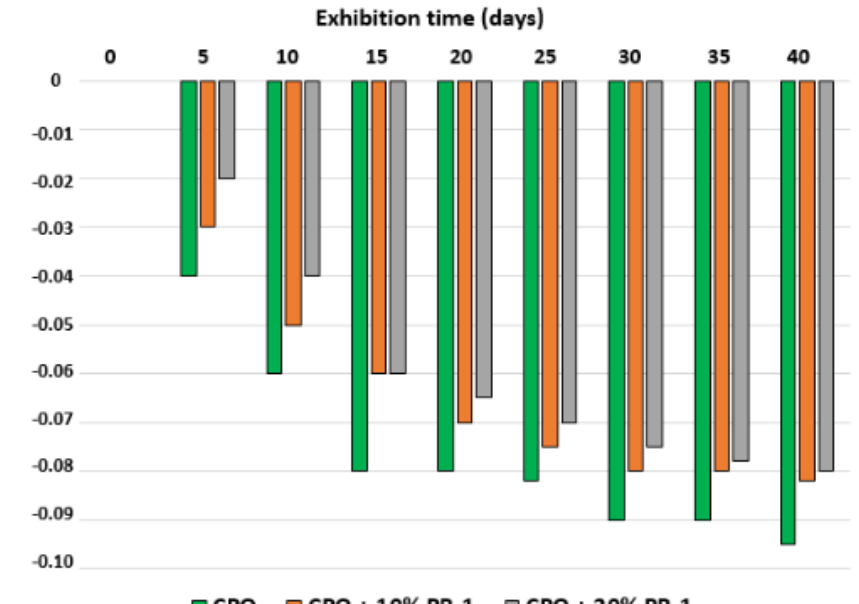
Figure 2. Variation of drying shrinkage in PR-1 sample.